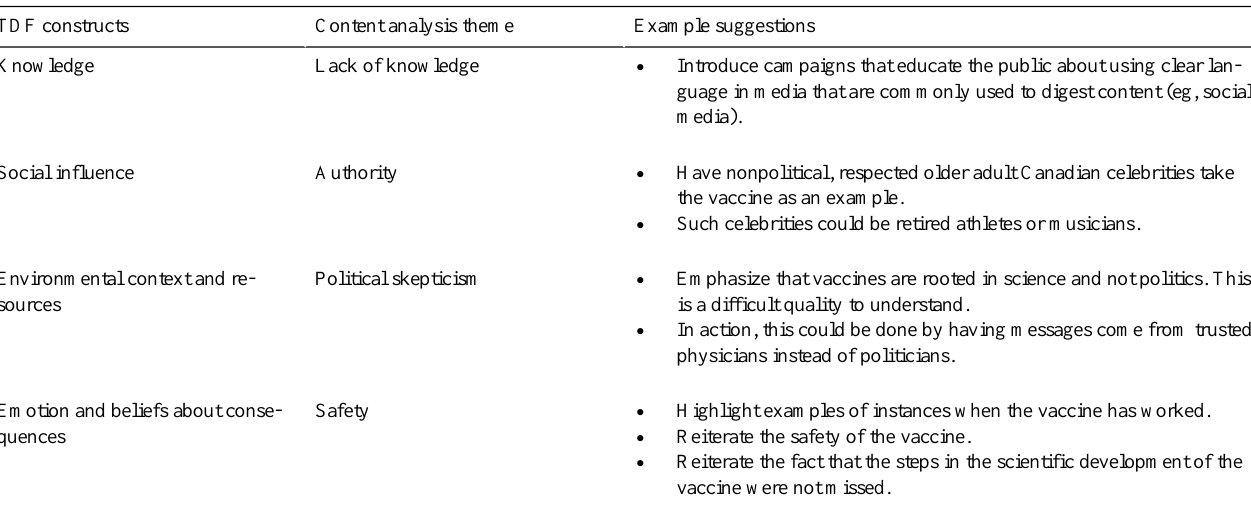
Table 1. Reasons for vaccine hesitation fell under several Theoretical Domains Framework (TDF) constructs (left column). The rightmost column provides examples of intervention suggestions for responding to vaccine hesitancy in relation to the TDF